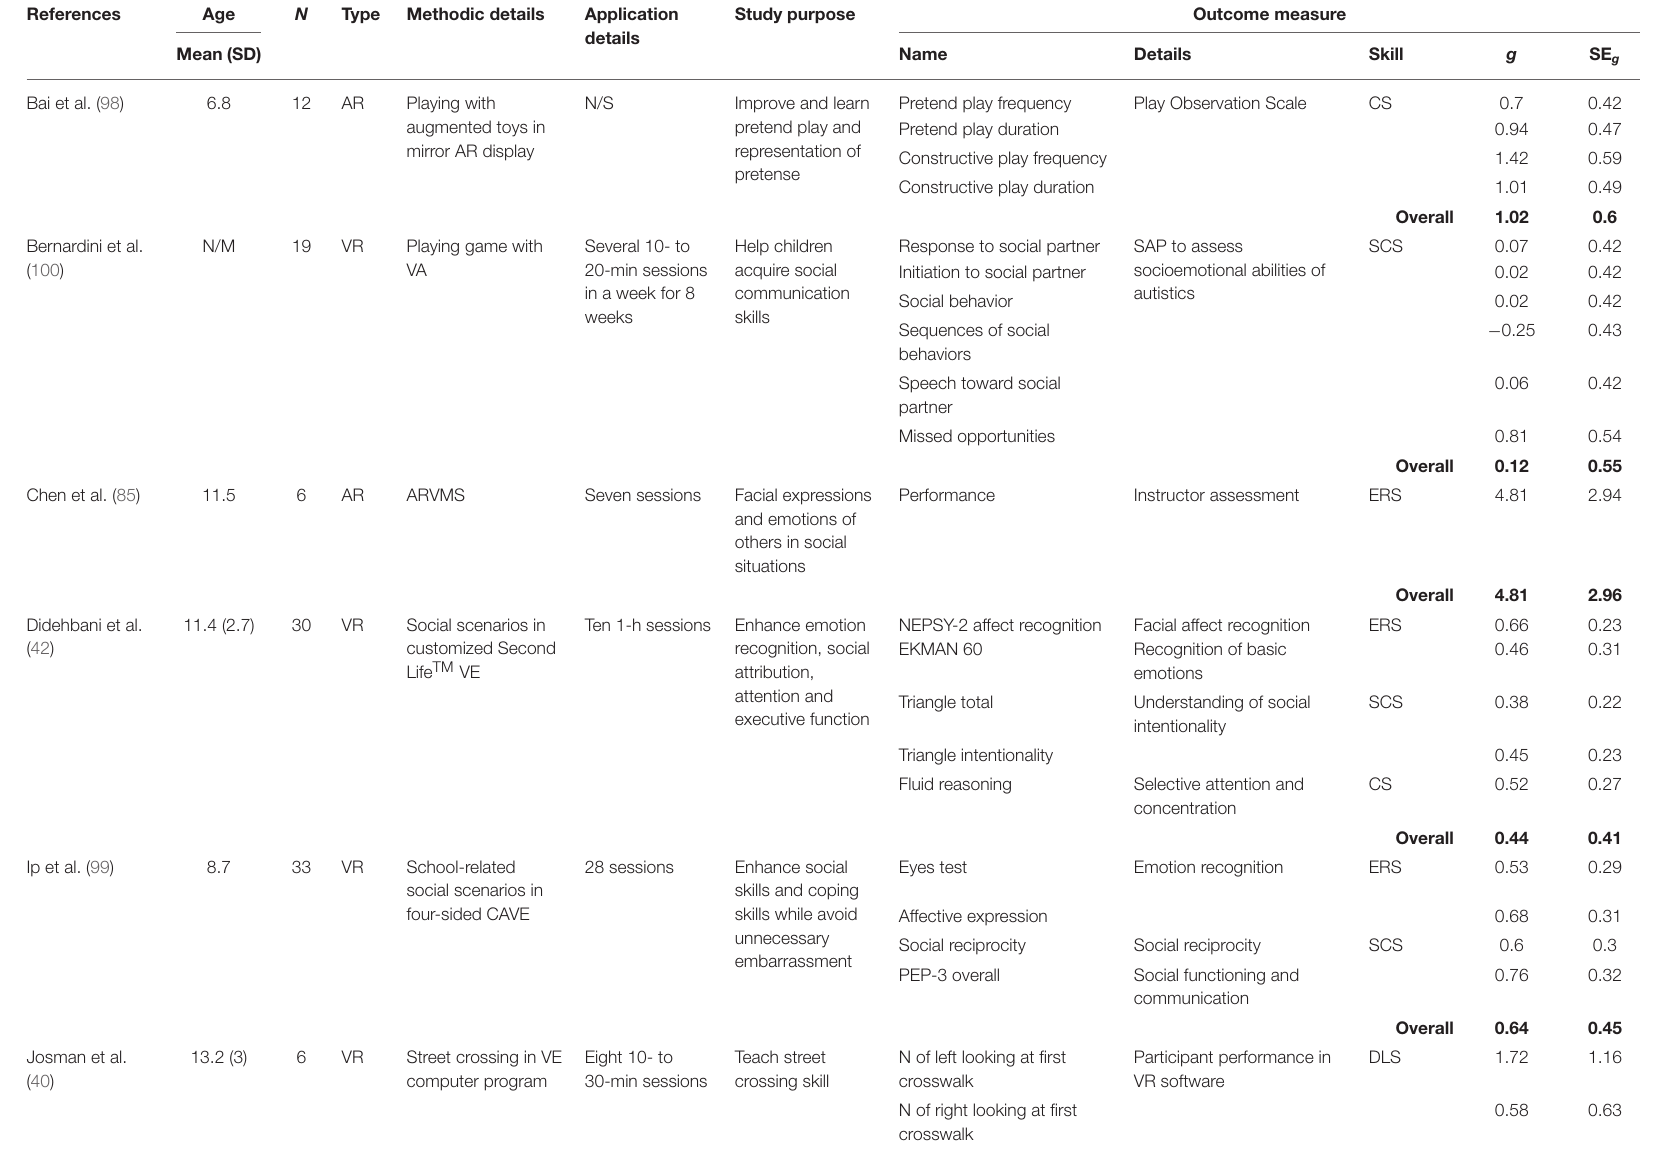
TABLE 1 | Characteristics of included studies, uncontrolled